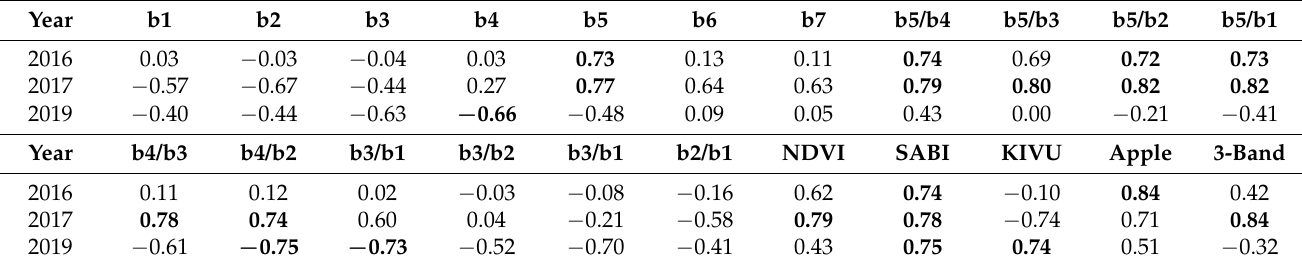
Table 3. Correlation coefficient (R) between measurements from 29 samples in the Guanting Reservoir and pixels’ value from Landsat-8 at corresponding time. The acquisition dates are 2016, 2017 and 2019, and the 22 variables include bands 1 to 7, ratio bands (b5/b4, b5/b3, b5/b2, b5/b1, b4/b3, b4/b2, b4/b1, b3/b2, b3/b1, b2/b1) and other indices (NDVI, SABI, KIVU, Apple, 3-band). Note that values with high correlation are shown in bold. The overall correlation of multiple band combinations is